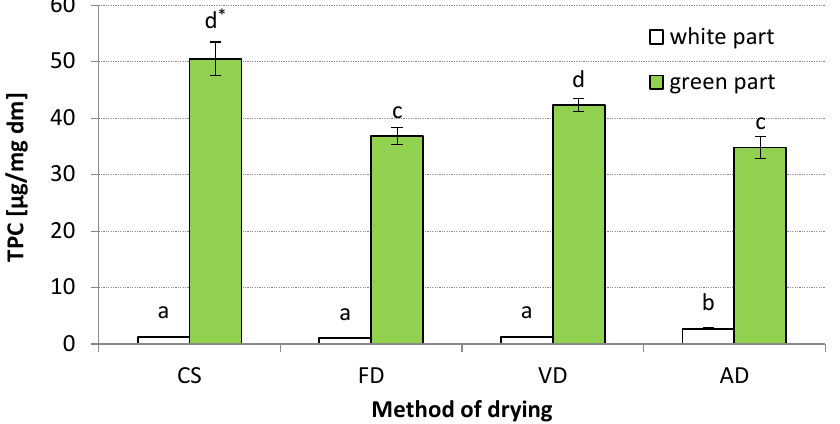
Figure 2. Total phenolic content in dried leek samples: CS—control sample, FD—freeze-drying, VD—vacuum drying, AD—air drying, WH—white shaft, GR—green shaft; * The values designated by the different small letters are significantly different (α = 0.05). Table 5. The analysis of variance for the total phenolic content in dried leek. Parameter Source of